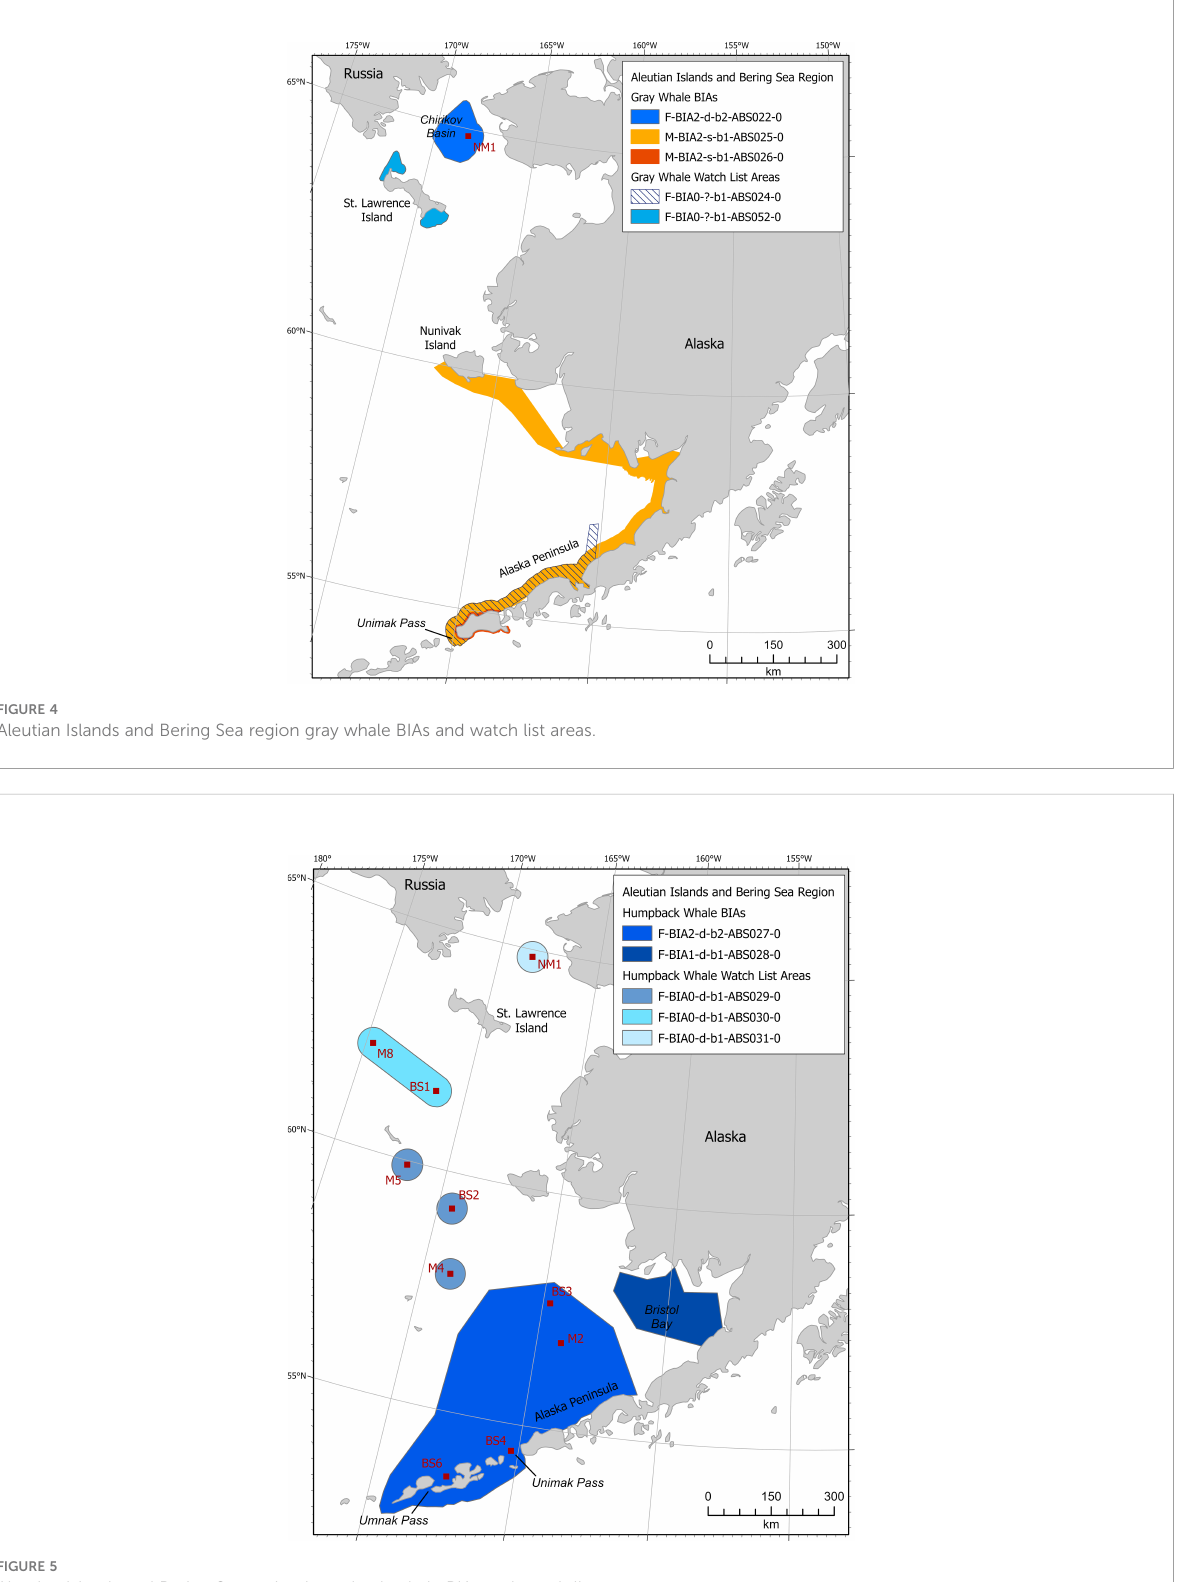
FIGURE 5 Aleutian Islands and Bering Sea region humpback whale BIAs and watch list